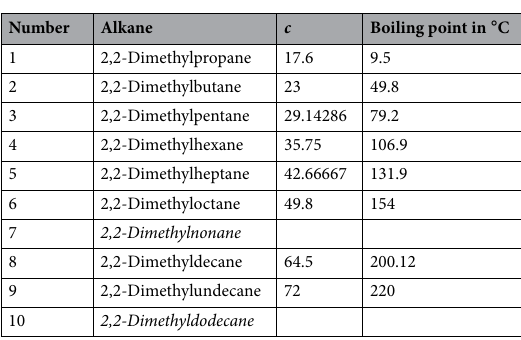
Table 5. Data for 8, 2,2-dimethyl